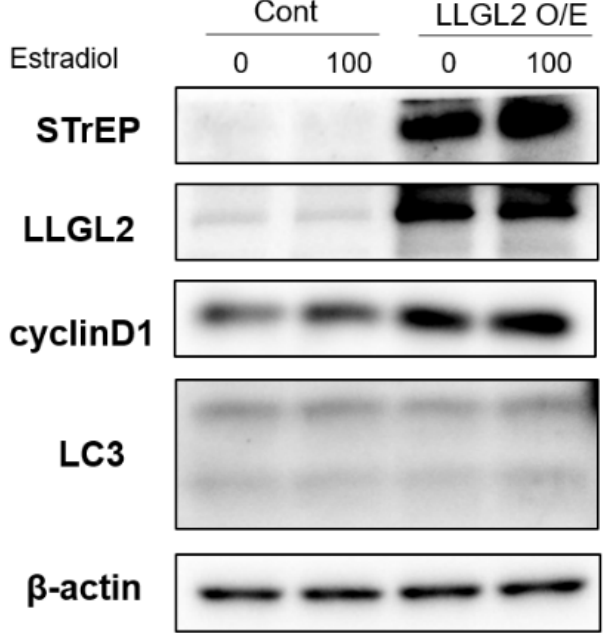
Figure 5. LLGL2 overexpression in E2-treated BPH-1 cells. BPH-1 cells were transiently transfected with a negative control vector (Cont) or with LLGL2 overexpression plasmid (LLGL2 O/E, Strep-tag pEXPR-IBA 105-LLGL2) for 24 h. After that, cells were treated with E2 (0 and 100 nM) for 24 h. Western blot data of STrEP, LLGL2, cyclinD1, and LC3 in E2-treated BPH-1 cells after LLGL2 overexpression are shown.